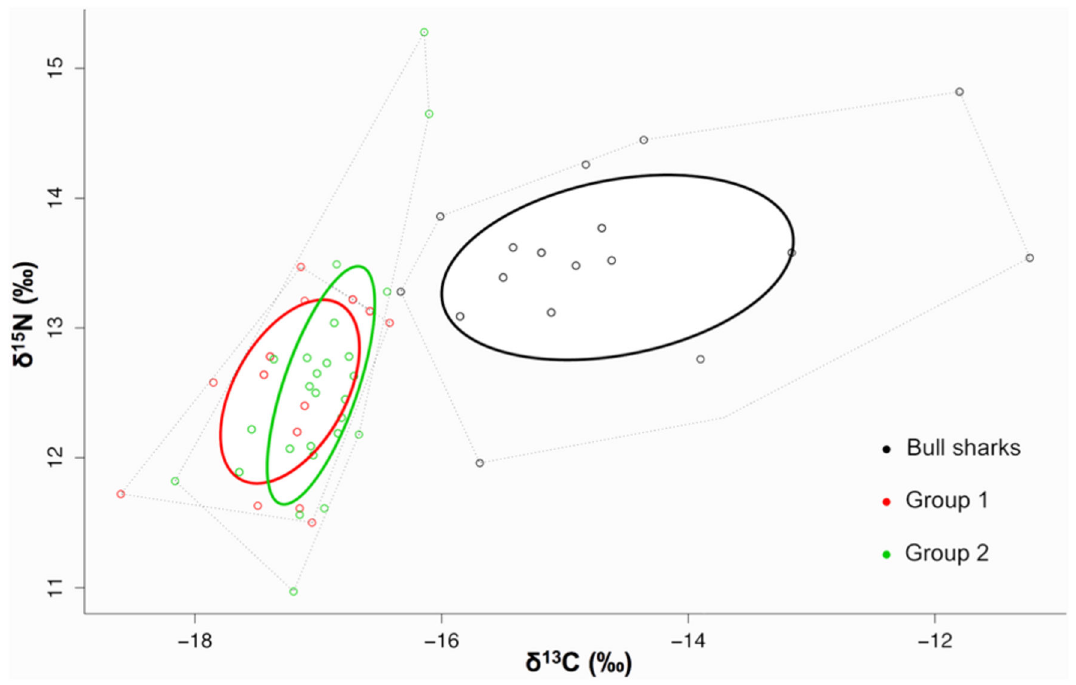
Figure 4. A dual isotope plot representing the niche widths of bull sharks (black line), fish group 1 (red line) and fish group 2 (green line). Calculated niche width is represented by the small sample size corrected ellipses (solid lines) and displayed in a δ 13 C-δ 15 N niche